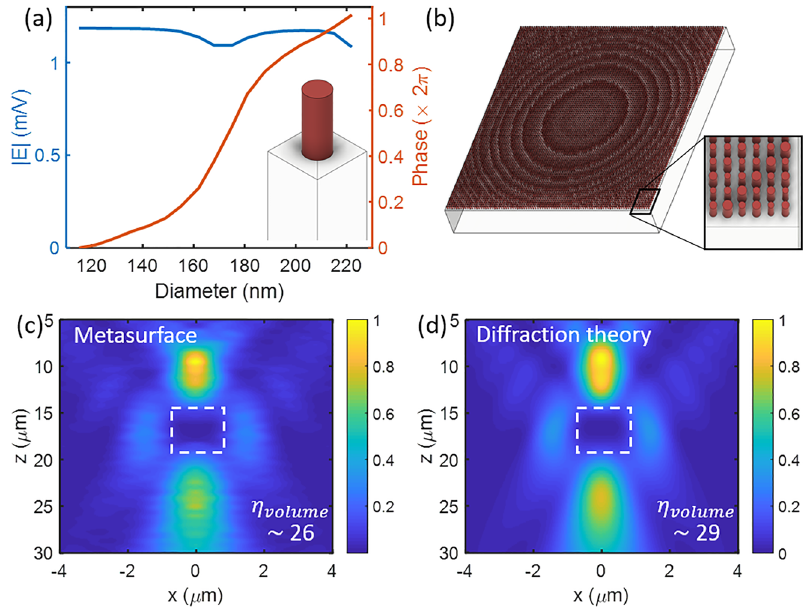
Figure 6: Demonstration of a volume bottle-beam trap using a crystalline silicon metasurface. (a) Transmitted field amplitude and phase as a function of the silicon cylinder diameter. The height of the cylinder is 360 nm, with a period of 330 nm, sitting on top of a fused-silica substrate. The source is a plane wave at a free-space wavelength of 770 nm launched from inside the silica substrate. (b) Simulated silicon metasurface. The dimension of the metasurface is 20 µm × 20 µm and the design is radially symmetric. The inset is a portion of the metasurface near its edge. (c) Simulated bottle-beam trap pro fi le using the metasurface in (b) via full 3D FDTD simulation. The metasurface was located at z = 0 μ m and was illuminated with a Gaussian beam of width of 5 μ m. η volume of the generated bottle-beamtrapis26.(d)Calculatedbottle-beamtrapusingdiffractiontheory.Theincident fi eldat z =0 μ mistheproductofthetransmission phase of the metasurface in (b) and a Gaussian beam of 5 μ m wide. This bottle-beam trap has an η volume of